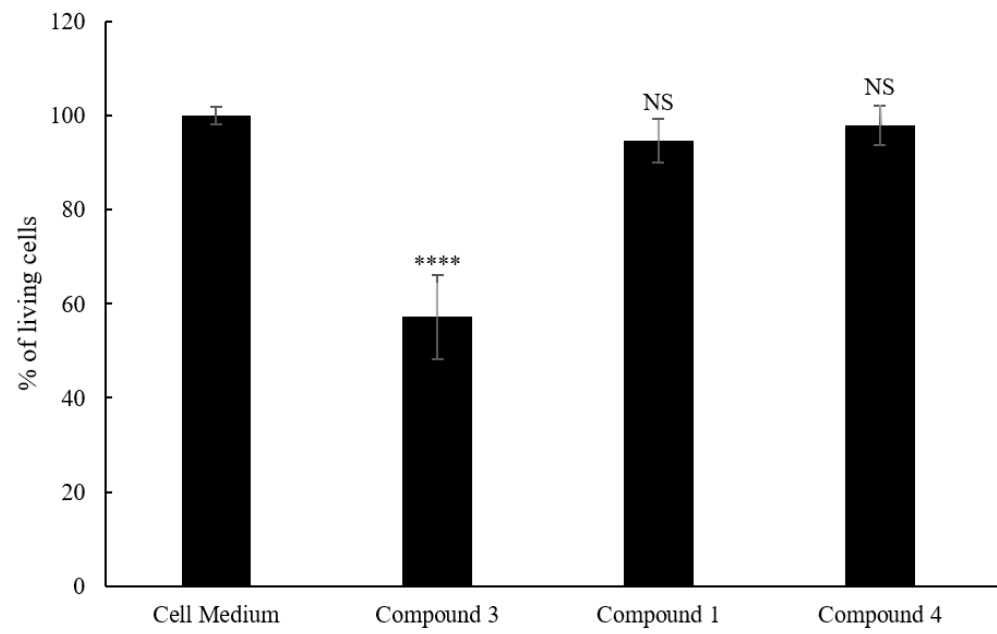
Figure 4. Viability of HaCaT cells after 6 h of incubation with compounds 1 , 3 and 4 . (NS: not significant; ****: p < 0.0001).